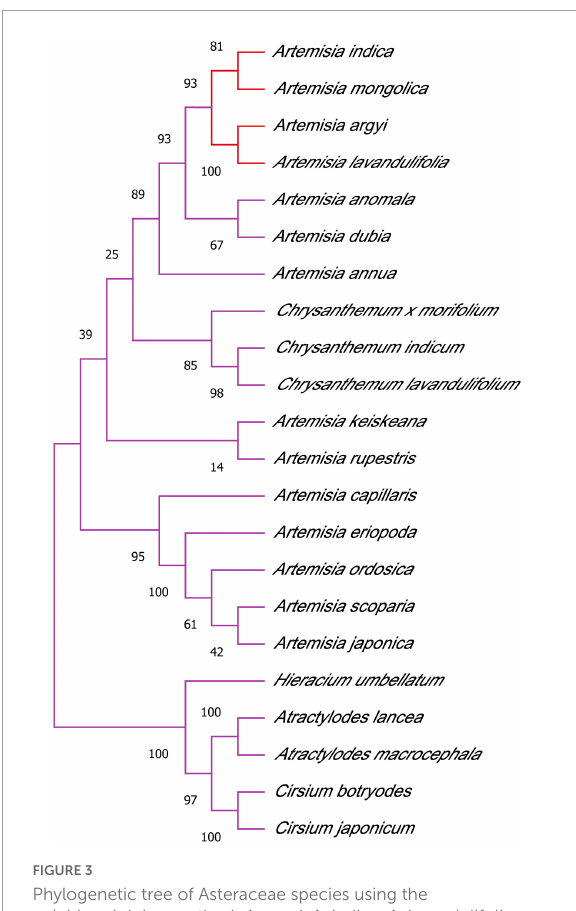
FIGURE3 Phylogenetic tree of Asteraceae species using the neighbor-joining method. A. argyi , A. indica , A. lavandulifolia , and A. mongolica are closely related.